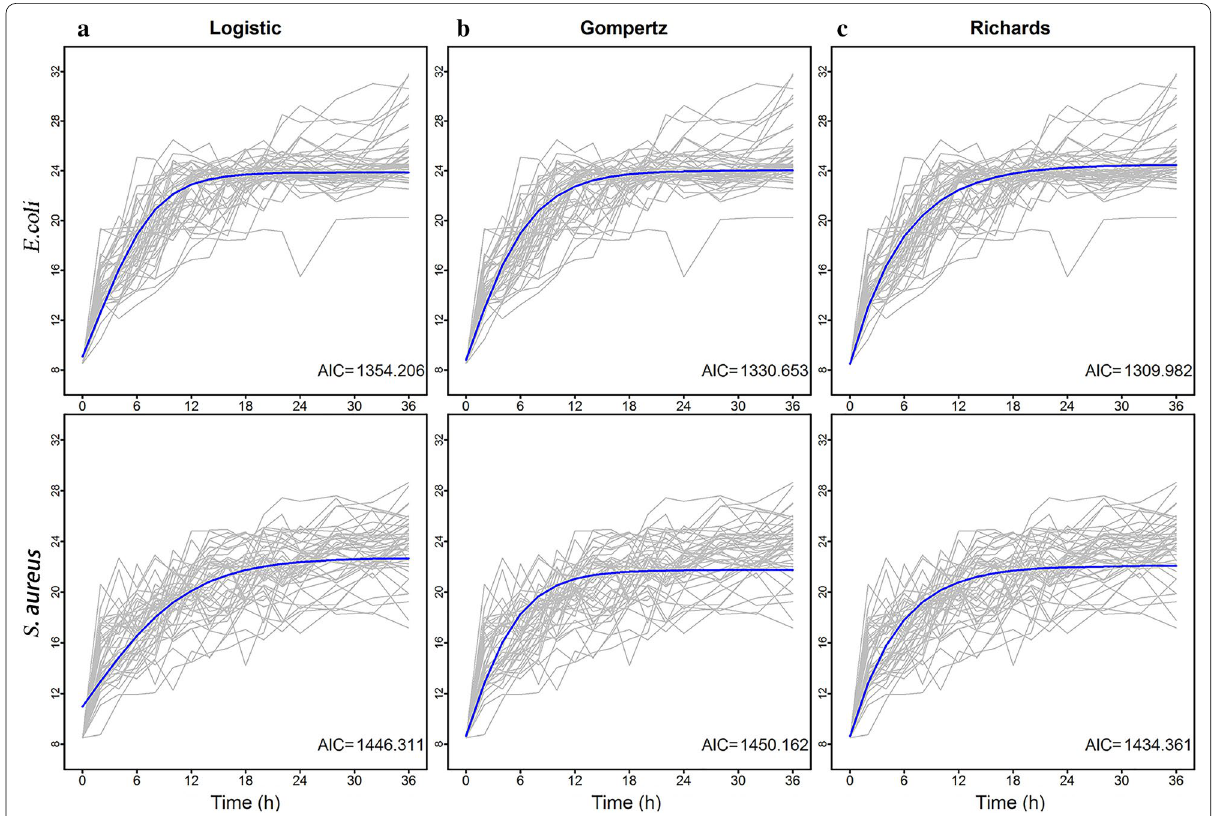
Fig. 1 Fitting growth curves of E. coli and S. aureus phenotypic data under three equations. a Logistic; b Gompertz; c